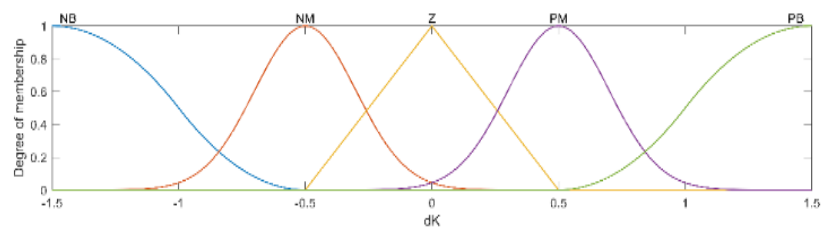
Figure 11. Fuzzy control output.